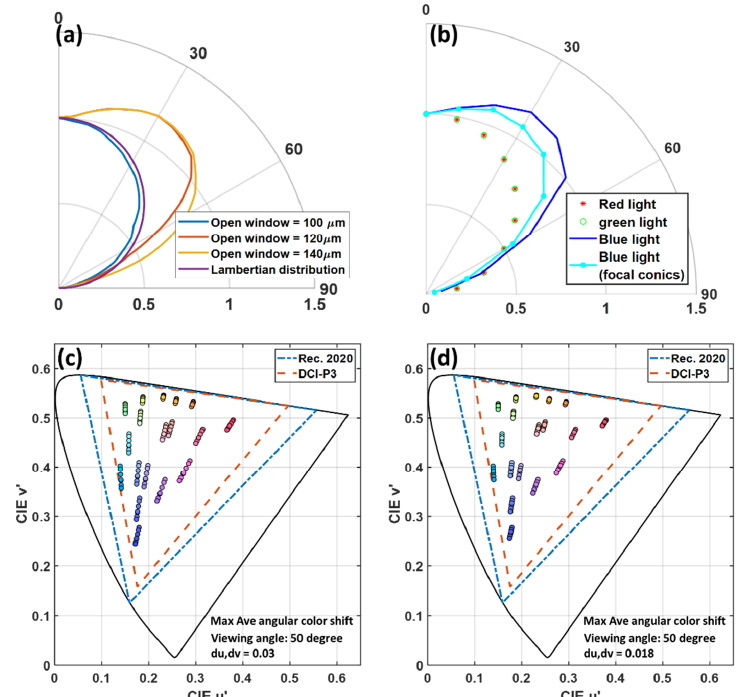
Figure 8. ( a ) Angular intensity distribution of the blue sub-pixels of different aperture size color conversion units. ( b ) Angular intensity distribution of red, green, and blue (RGB) sub-pixels (aperture size = 120 μm). Simulated color shift of the first 18 colors in Macbeth ColorChecker from 0° to 60° viewing angle for color conversion micro-LED display ( c ) without FC-CLC film and ( d ) with FC-CLC film.